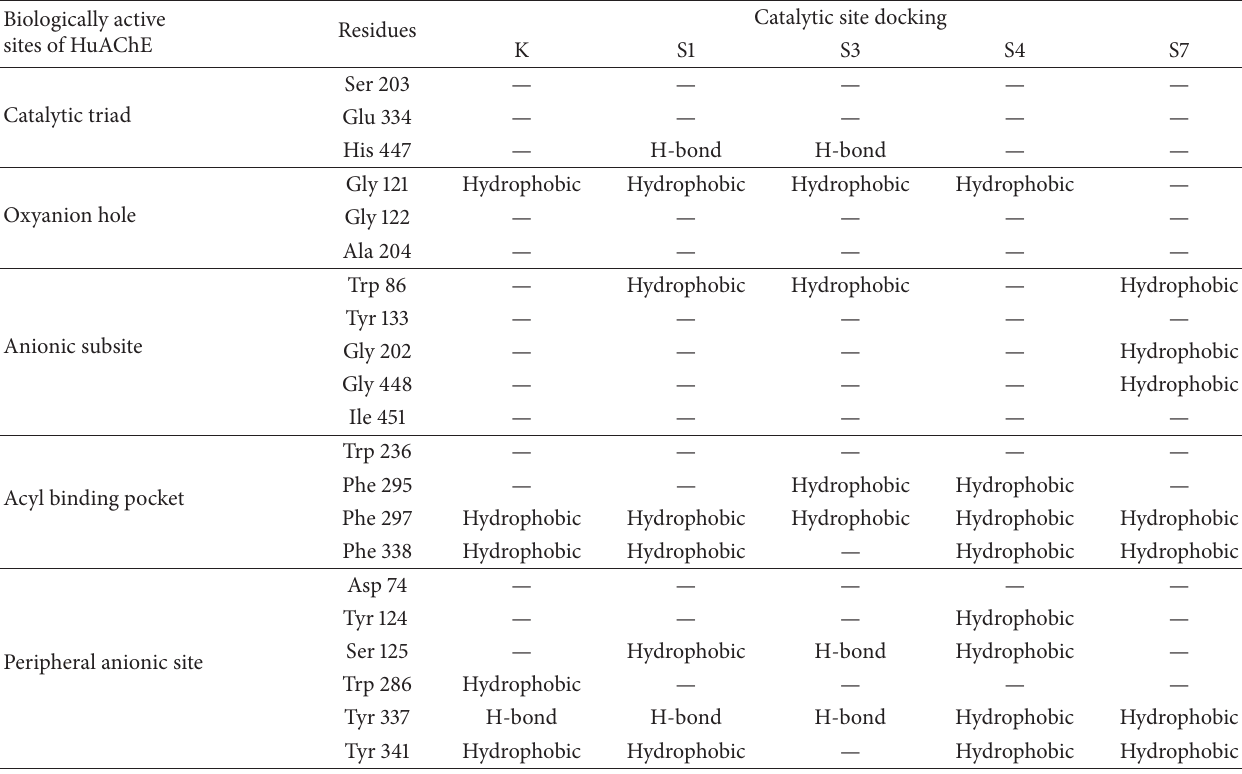
Peripheral anionic site